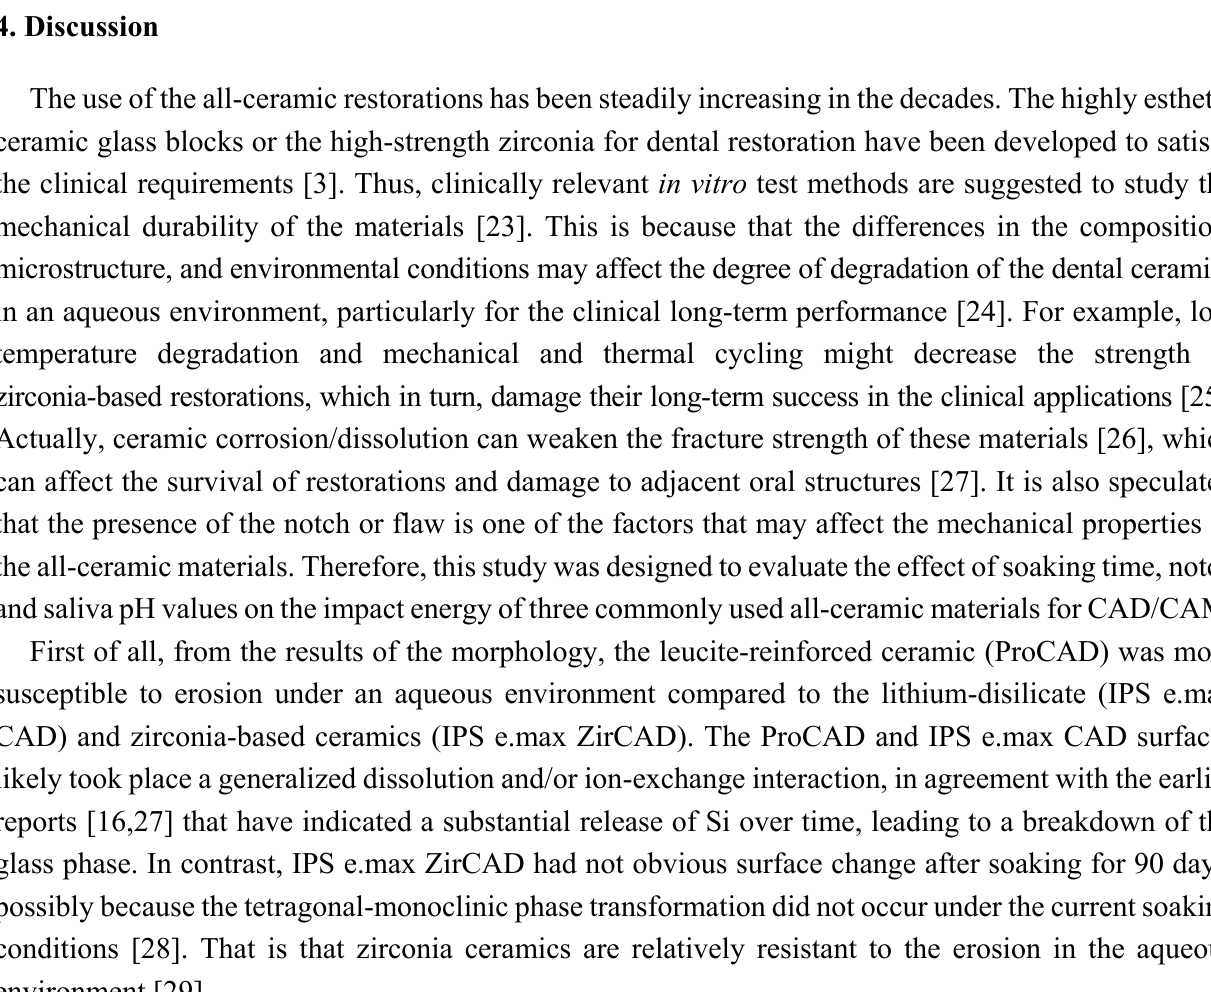
Figure 7. The variations in the impact energy of the three all-ceramic dental restorations without notch after soaking in artificial saliva with different pH values for 90